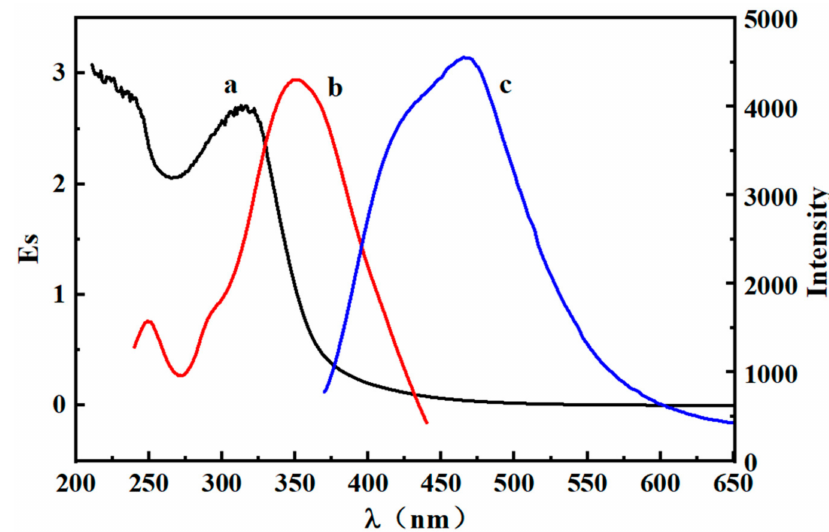
Figure 4. UV − vis and PL absorption spectra of